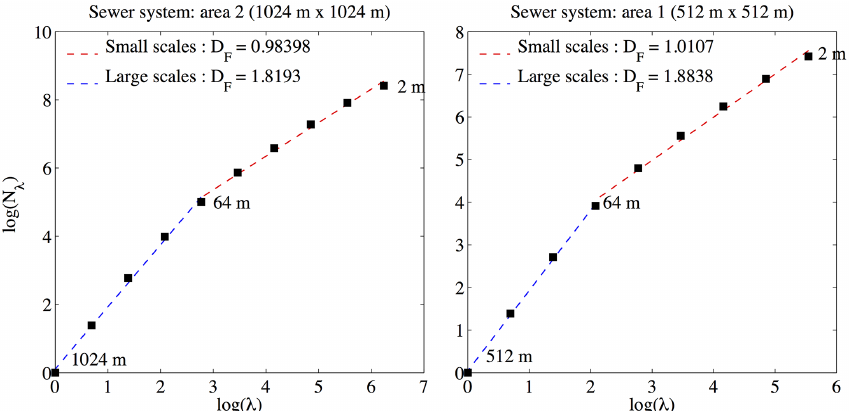
Figure 10. Fractal analysis of the sewer system structure. Two ranges of scale are identified in both areas; D f is equal to 1 at small scales (2–64m) and 1.8 for large scales l ≥